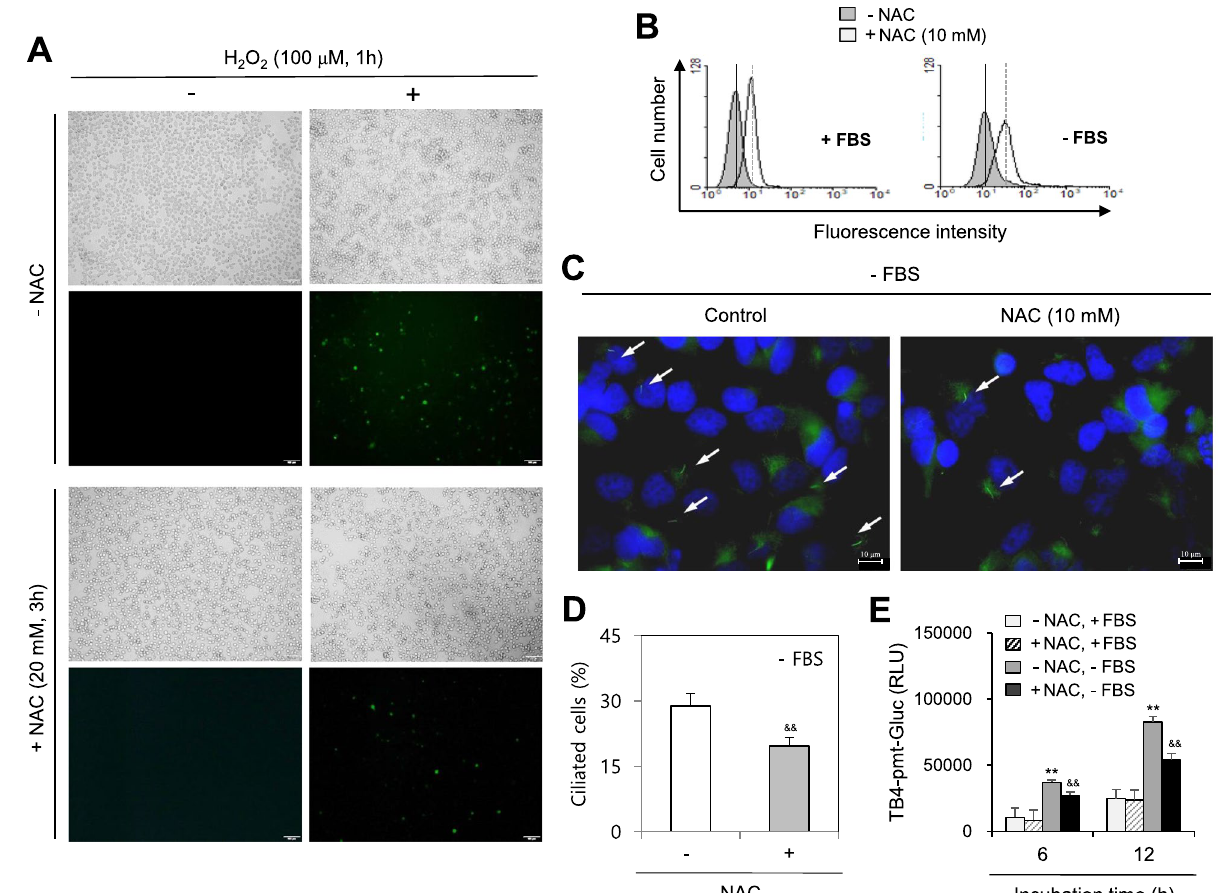
Figure 2. N-acetylcysteine (NAC) decreased reactive oxygen species production, primary cilia formation and the expression of thymosin beta-4 under serum-deprived (SD) condition. ( A ) Cells were treated with 100 μM H 2 O 2 in the absence or presence of NAC. Cells were incubated with DCF-DA and ROS production was observed under the fluorescence microscope. ( B – D ) Cells were incubated under SD condition in the absence or presence of NAC. Cells were treated with DCF-DA and ROS production was measured by FACS analysis. Vertical dotted lines and solid lines indicate mean fluorescence intensity (MFI) for the increase and the inhibition of ROS production, respectively ( B ). Cells were fixed and stained with antibody against Ac-tubulin (green) and DAPI (blue). The representative image of primary cilia was observed with 400X magnification under fluorescence microscope. White arrows indicated primary cilia ( C ). The ciliated HeLa cells out of more than 1000 cells in the absence (white) or presence (grey) of NAC were counted. PC frequency was evaluated by the blinded double scoring ( D ). ( E ) HeLa cells were transfected with pEZX-PG02-TB4-promoter Gaussia luciferase (Gluc) plasmid and incubated with 5% or 0% FBS for up to 12 h. The activity of Gluc in cultured media was measured with luminometer using Gluc substrate. Each result was the representative of experiments performed at least four times and each experiment was performed with four samples (n = 4) in the same group. Data in bar graphs represents the means ± SD. ** p < 0.01; significantly different from 5%-treated control group ( E ). && p < 0.01; significantly different from NAC-untreated group in 0% FBS ( D , E